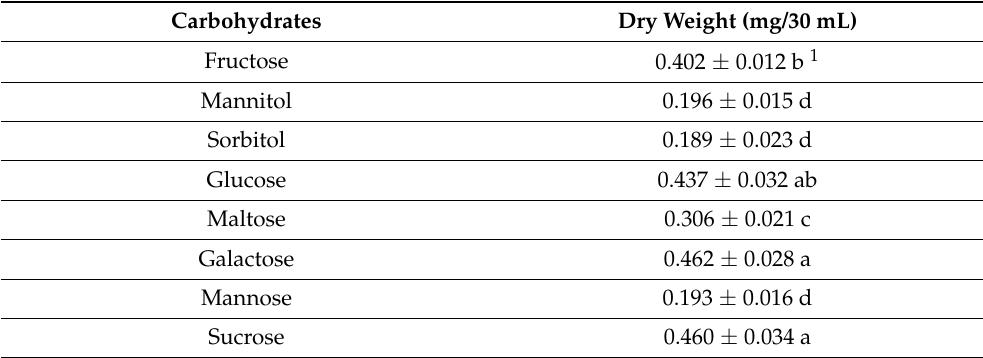
Table 1. Effects of different carbohydrates on growth in hairy root cultures A. rugosa.